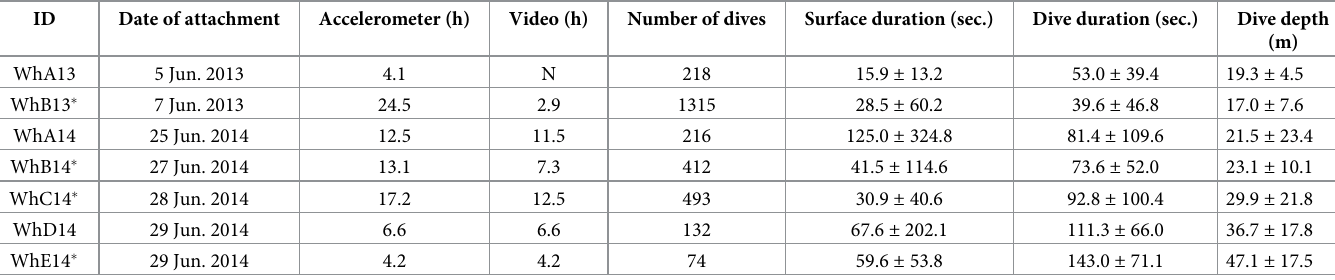
Table 1. Tagging results of seven humpback